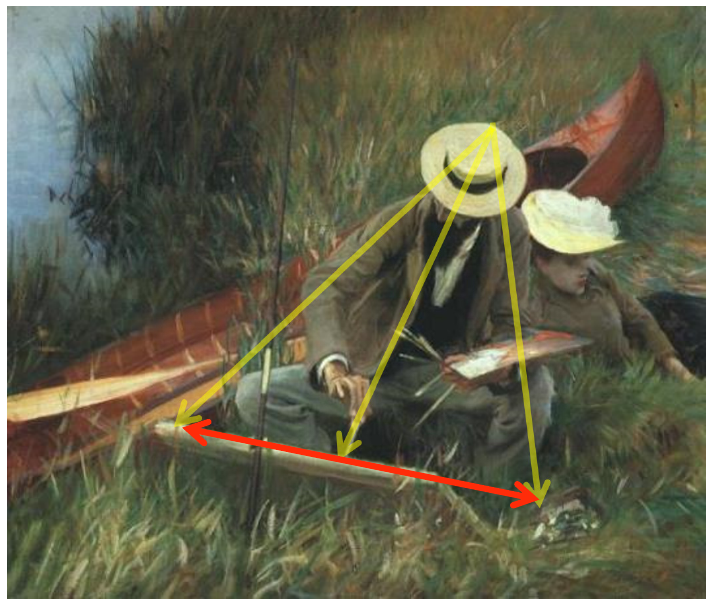
Figure 8. John Singer Sargent, An Out-of-Doors Study [with diagram], Brooklyn Museum of Art, Museum collection fund 20.640 (Photo: Brooklyn Museum).